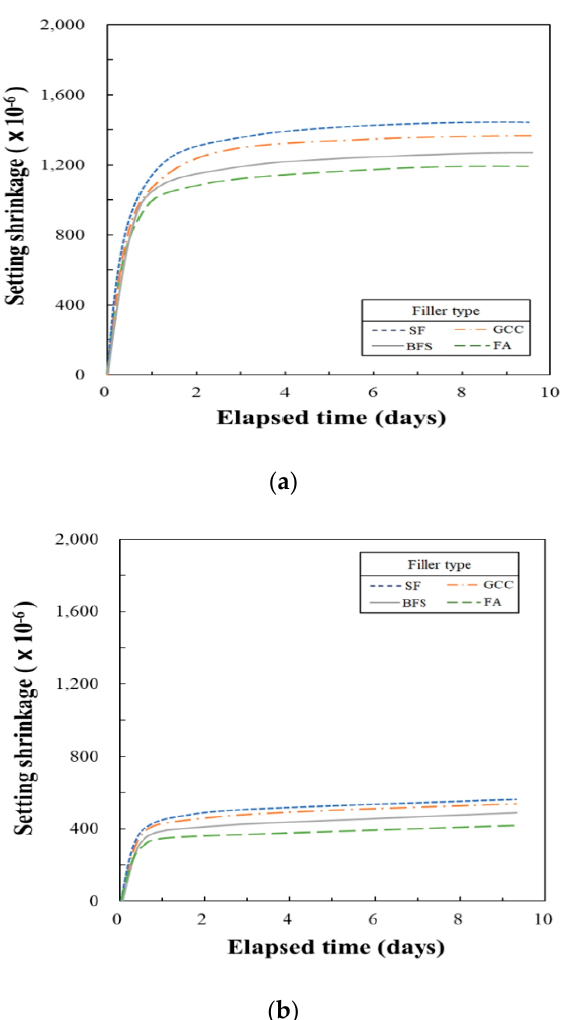
Figure 8. Variations in setting shrinkage by hardener and filler type: ( a ) AAMT hardener and ( b ) CAMT hardener.